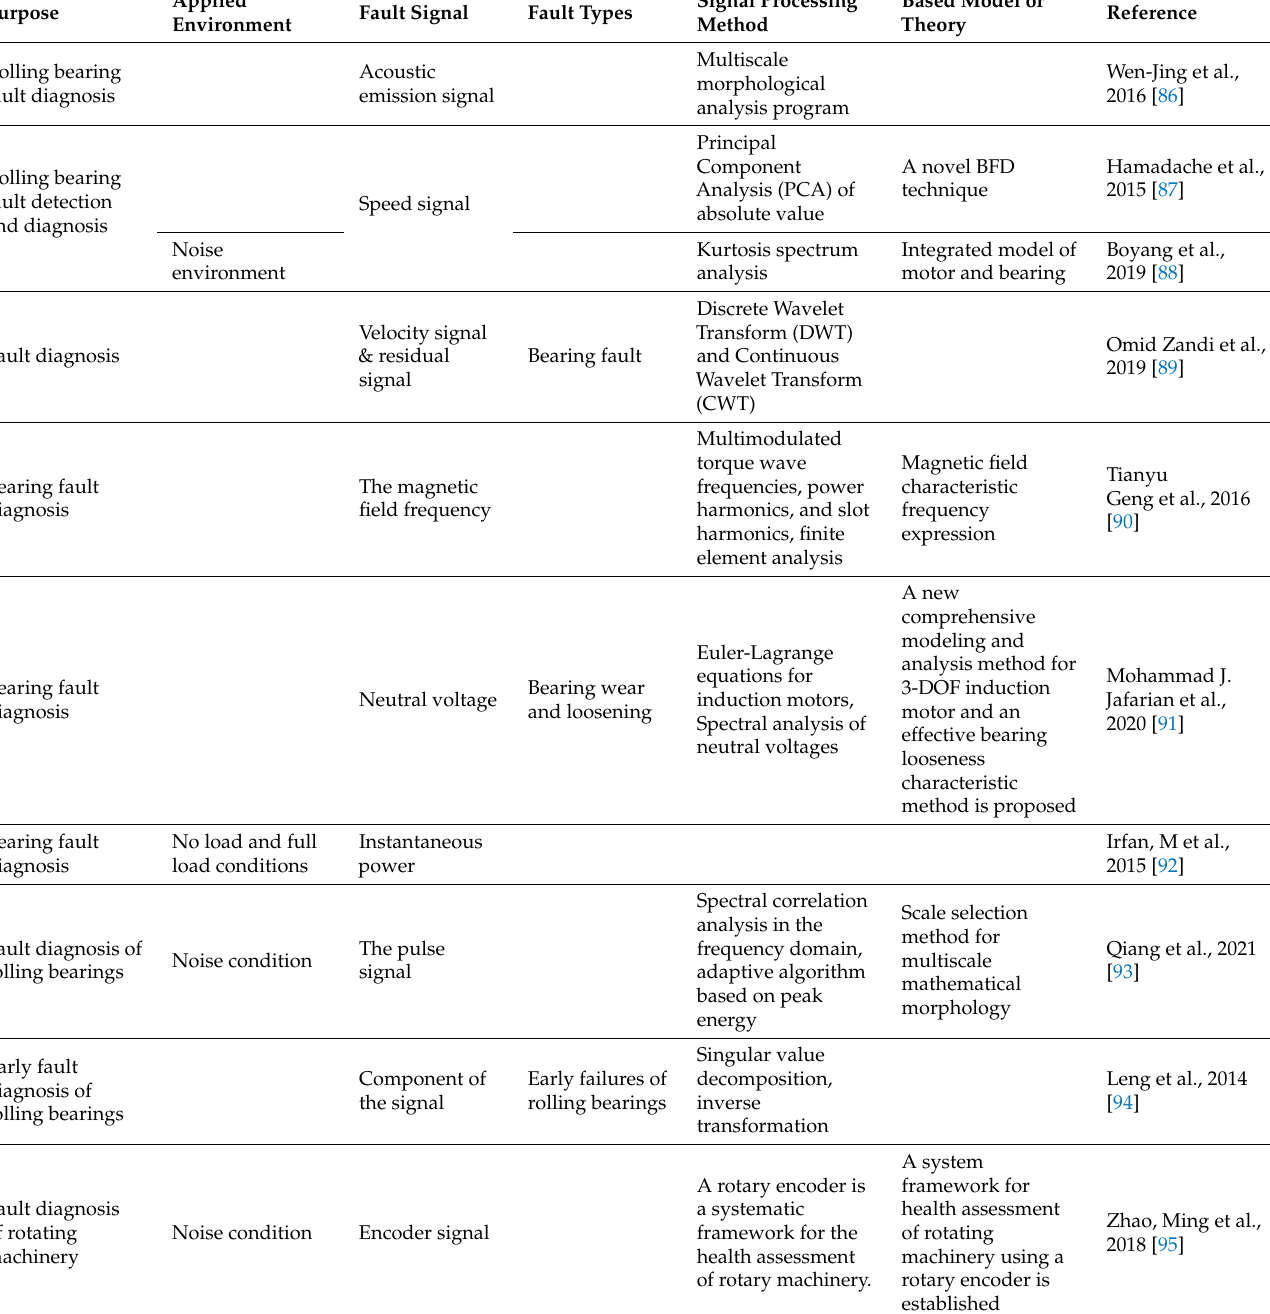
Table 8 summarized this section below for more clarity. Table 8. Summary and comparison table of other methods based on one-dimensional